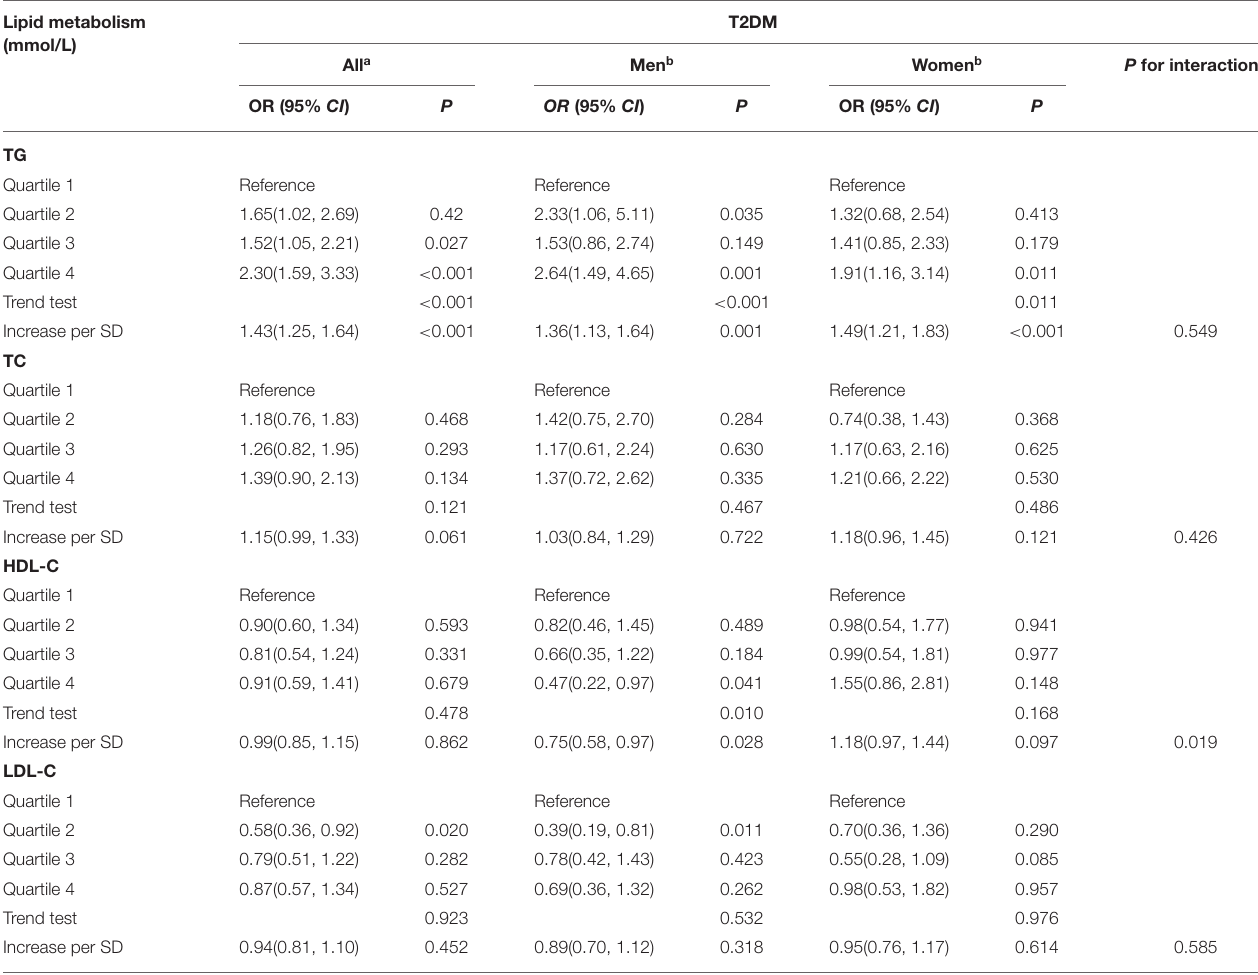
TABLE 3 | Association between lipid metabolism and T2DM. Lipid metabolism (mmol/L)